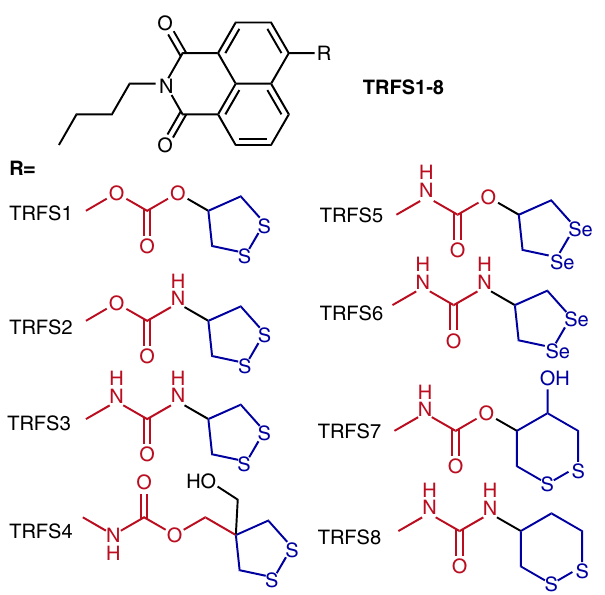
Fig. 3 Chemical Structures of TRFS series probes. The chemical structures of TRFS1-8 were presented